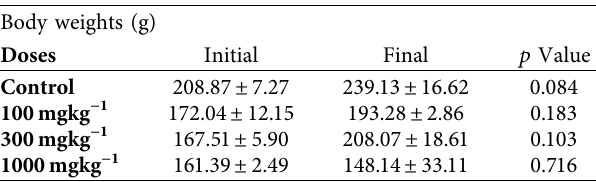
Table 3: Body weight (g) of animals dosed with the AAE in the sub- acute toxicity tests.